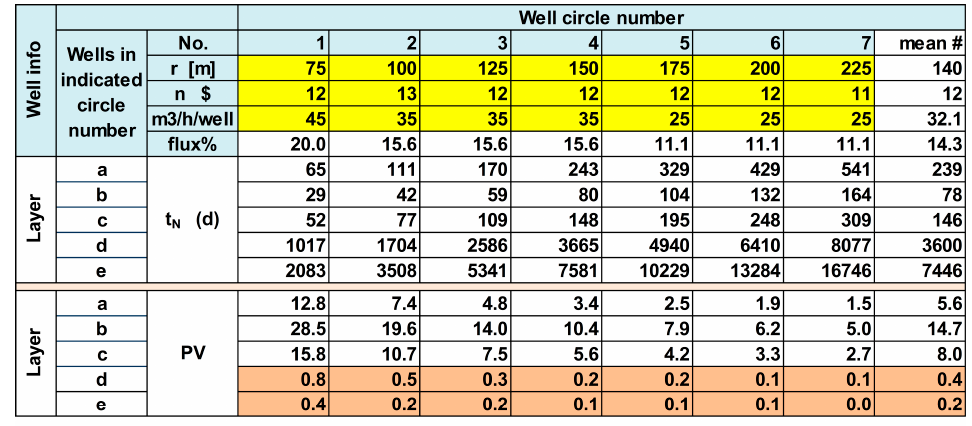
Figure 6. Calculated travel times ( t N ) to the 7 well rings around each recharge basin during infiltration, in aquifer layers a–e, and the number of pore volumes (PV) after 824 d of nonstop infiltration. PV = 824/ t N . Orange cells have PV < 1, indicating that DSW did not arrive during the recharge period.